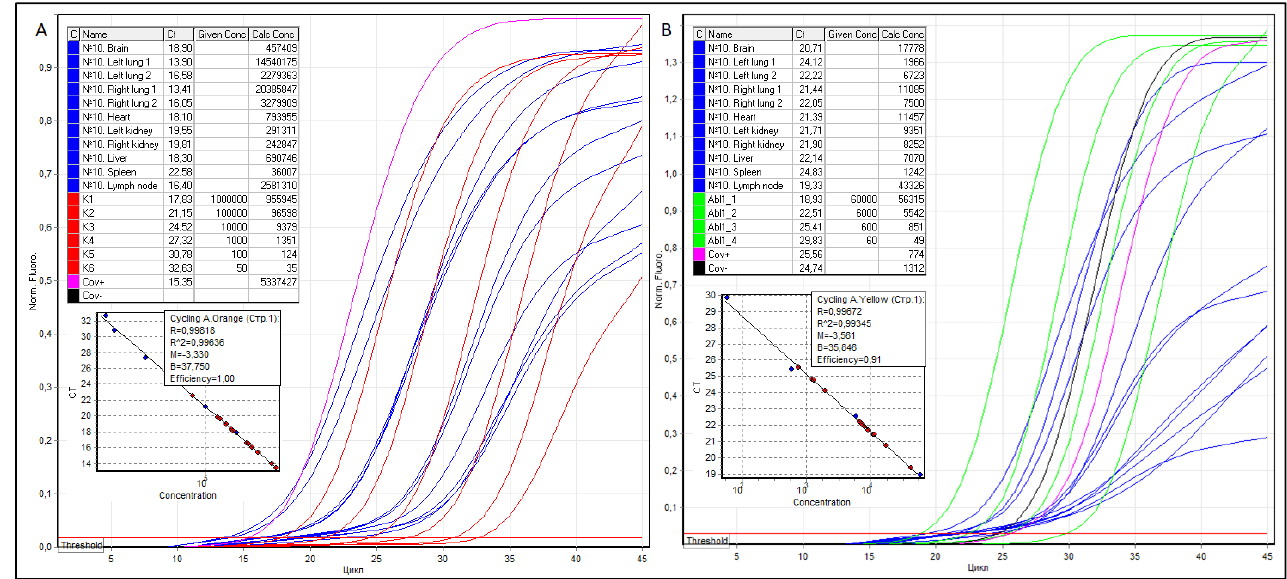
Figure 4. Threshold cycles (Ct), the concentration of serial dilutions of pGEM ® ‐ T Easy plasmids, the copy number of SARS ‐ CoV ‐ 2 ( A ) and ABL1 ( B ) cDNA, as well as RT qPCR graphical curves of patient No. 10. The samples are colored blue, SARS ‐ CoV ‐ 2 serial dilutions—red, ABL1 serial dilutions—green.